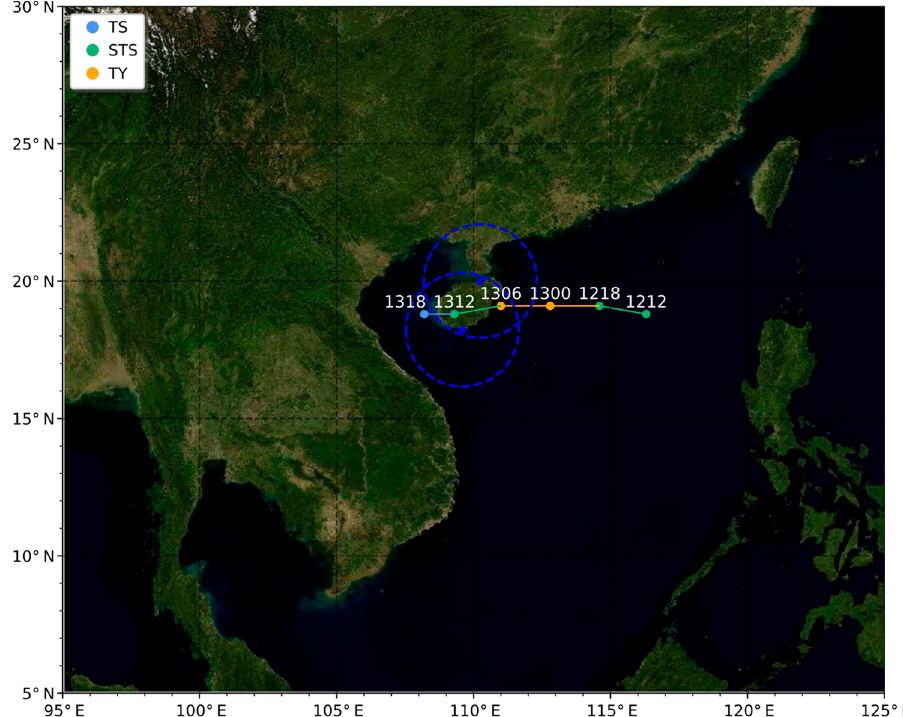
Figure 1. The simulated domain with the best track for Kompasu from 1212 UTC 12 to 1318 UTC 13 October 2021. The radar locations (blue asterisks) of Sanya (SYRD) and Haikou (HKRD), maximum detectable range (230 km) circles are also indicated. The type of TC is identified by color: tropical storm (TS), severe tropical storm (STS), typhoon (TY).